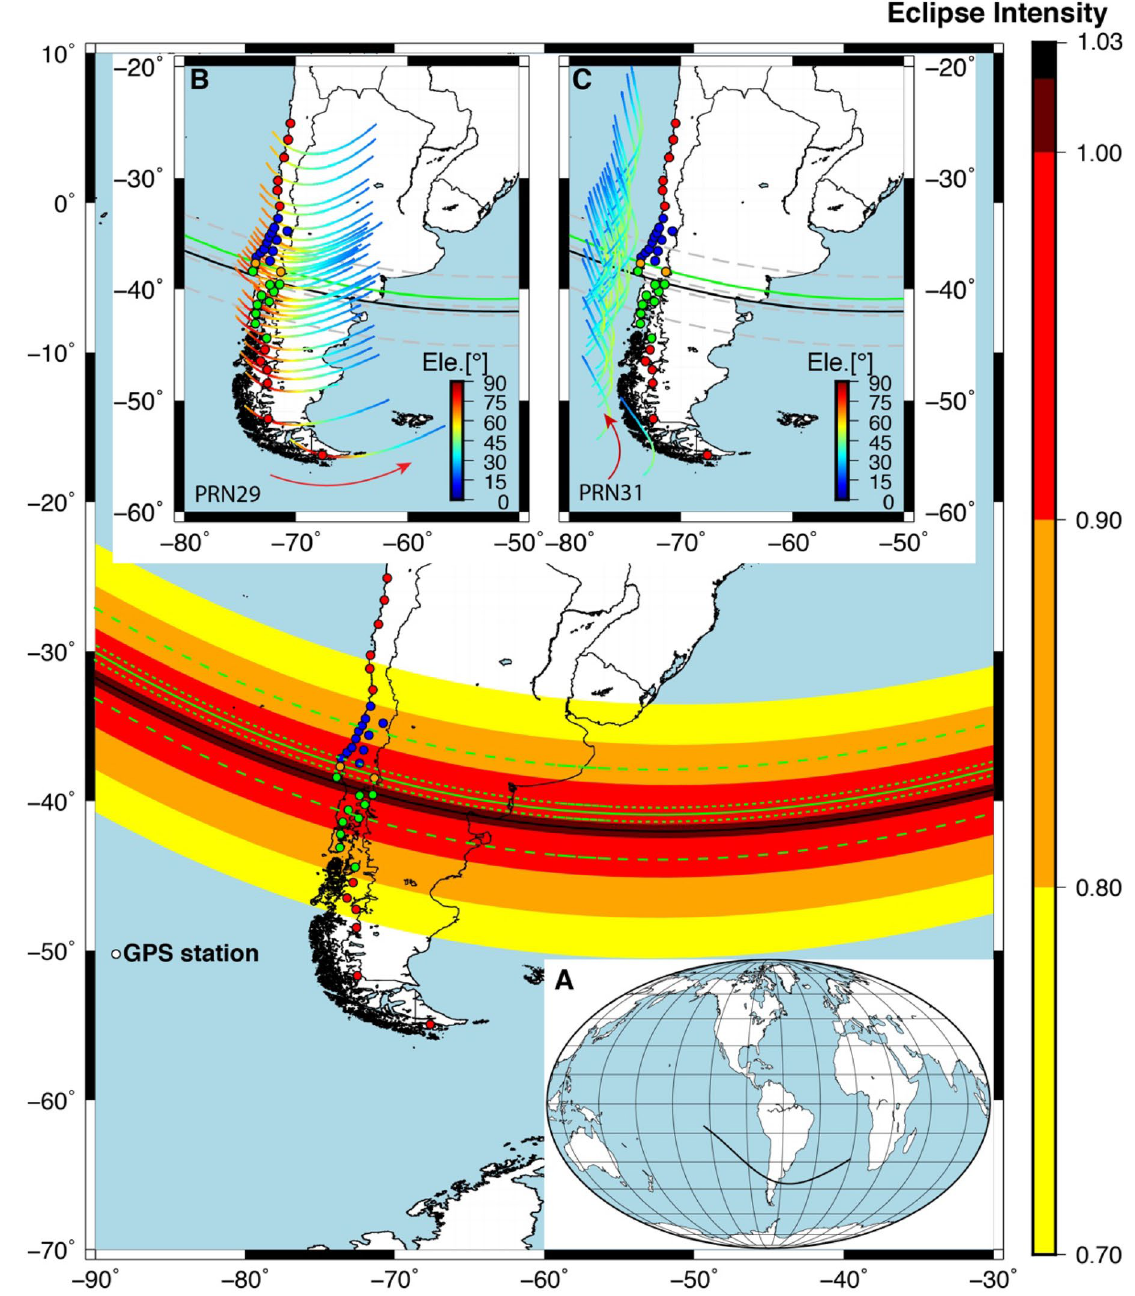
Figure 1. Geographic map of Chile and the total solar eclipse on Dec 14, 2020. The color dots show the GPS sites for TEC analysis. The orange color dots represent totality path at altitude 350 km for the TEC analysis. The blue dots represent the north GPS site of the totality and green color dots south of the totality. The red dots show GPS sites away from the 80% totality region. Inset ( A ) the path of the total solar eclipse central line on the world map. ( B ) The elevation of GPS PRN29 path at 350 km altitude with respect to ground GPS sites with color table from blue to red and IPP represent on the path with color circles. ( C ). The elevation of GPS PRN31 path at 350 km altitude with respect to ground GPS sites with color table from blue to red and IPP represent on the path with color circles. The Figure is prepared using the GMT 5.4.5 37